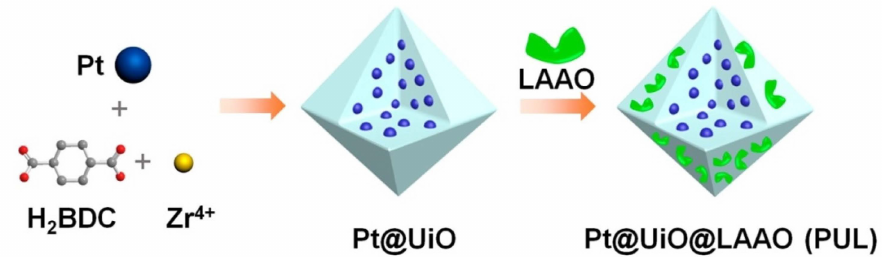
Figure 10. Preparation of a Pt/LAAO catalyst [181]. Reprinted with permission from [181]. Copyright (2020) American Chemical